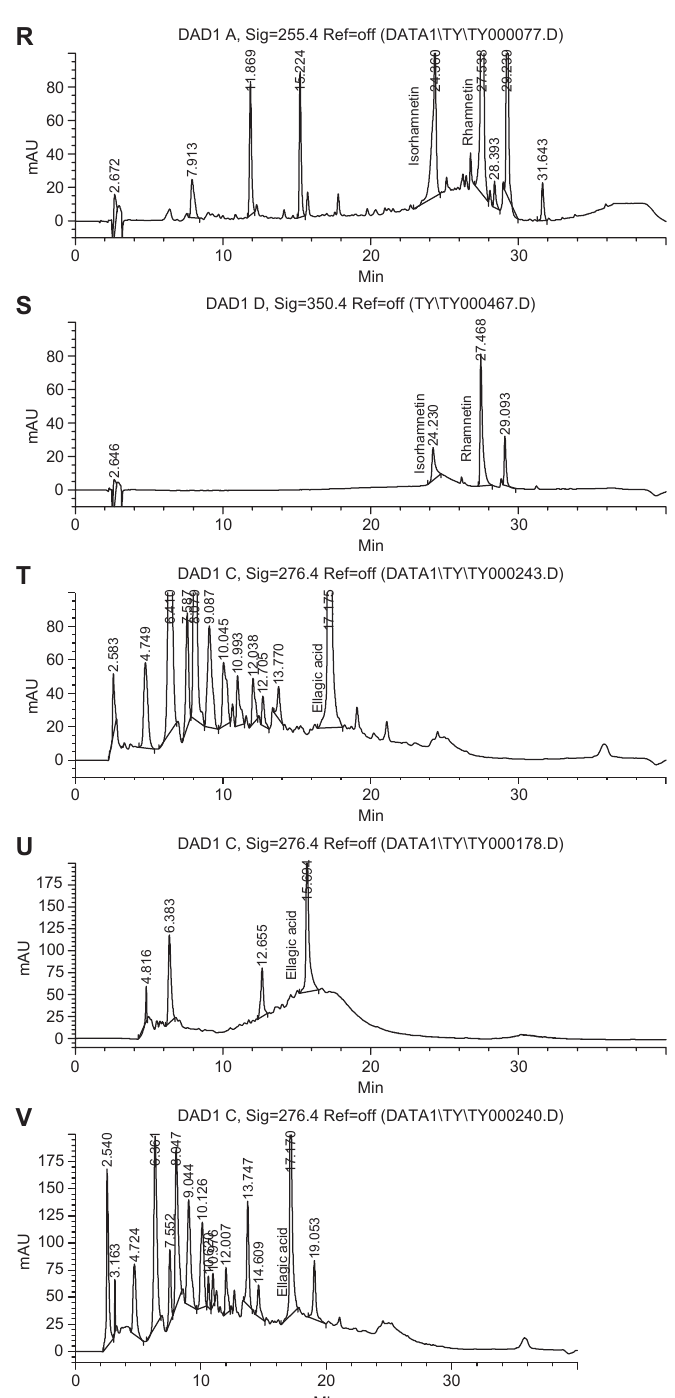
Figure 3 Chromatograms of undyed samples of silk and wool, newly dyed samples of silk and wool, plant extract samples as reference stan- dards (A) undyed silk sample mordanted with alum; (B) undyed wool with alum mordant; (C) Dactylopius coccus Costa extract; (D) chromato- gram of dyed silk with cochineal and Quercus infectoria Olivier (alum mordant); (E) Ararat kermes ( Porphyrophora hameli ) extract; (F) dyed silk with Ararat kermes ( Porphyrophora hameli ); (G) Kermes vermilio extract; (H) dyed wool with Kermes vermilio (tin mordant); (I) Kerria lacca Kerr extract; (J) dyed wool with Kerria lacca Kerr; (K) Rubia tinctorum L. extract; (L) dyed silk with madder ( Rubia tinctorum L.); (M) dyed silk with Rubia tinctorum L. and Quercus infectoria Olivier; (N) weld ( Reseda luteola L.) extract; (O) dyed wool with weld ( Reseda luteola L.); (P) dyed silk with weld ( Reseda luteola L.); (Q) Rhamnus petiolaris Boiss. extract; (R) dyed silk with Rhamnus petiolaris Boiss; (S) dyed wool with Rhamnus petiolaris Boiss; (T) dyed wool with Quercus infectoria Olivier extract; (U) dyed wool with Quercus infectoria Olivier (iron mordant); (V) dyed wool with Quercus ithaburensis